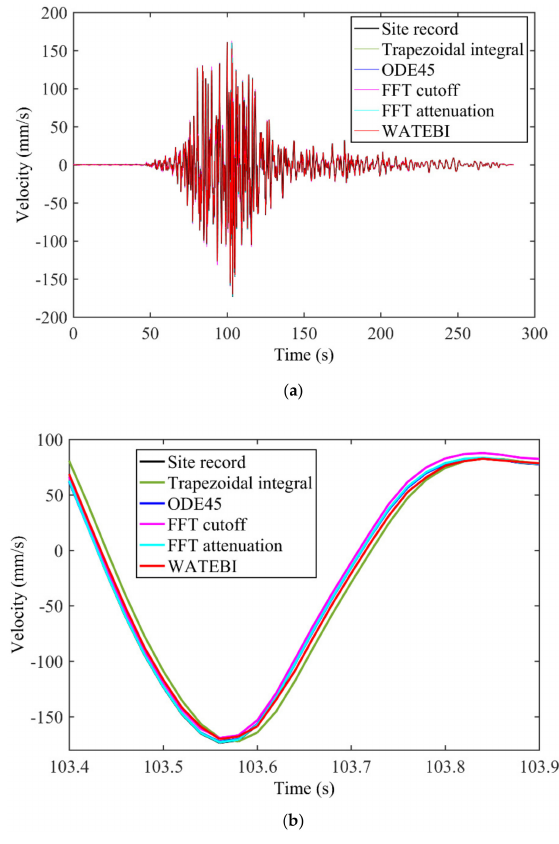
Figure 11. Velocity of Kaikoura ground motion: ( a ) Full duration; ( b ) Enlarged detail at largest